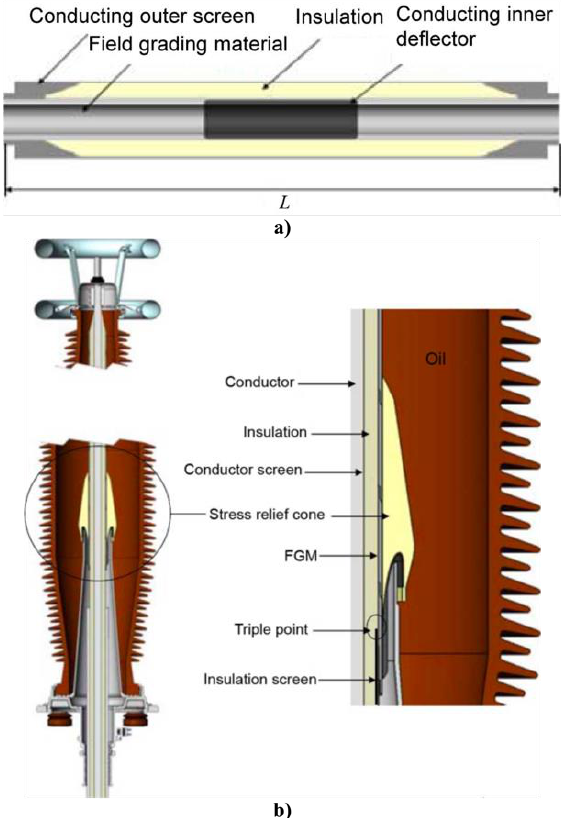
Figure 50. Cable accessories with field-grading materials: ( a ) typical prefabricated joint design and ( b ) HVDC cable termination. © 2021 IEEE. Reprinted, with permission, from [37]. Ghorbani et al. reported the difference between the tangential electric field along the cable–joint interface for a joint with geometric and nonlinear resistive grading (see Figure 51) [37].